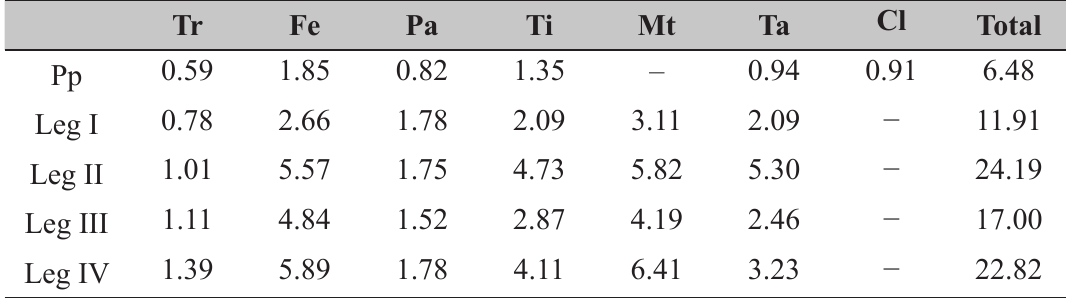
Table 6. Leg measurements of Lacronia serripes (Mello-Leitão, 1923), ♂ (MZSP